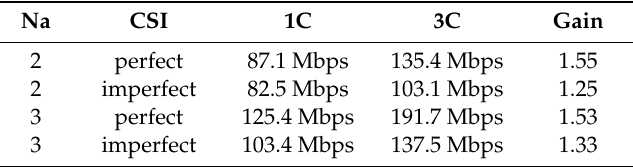
Table 4. Average throughput per user with perfect and imperfect channel estimation and the corresponding throughput gain. CSI = channel status